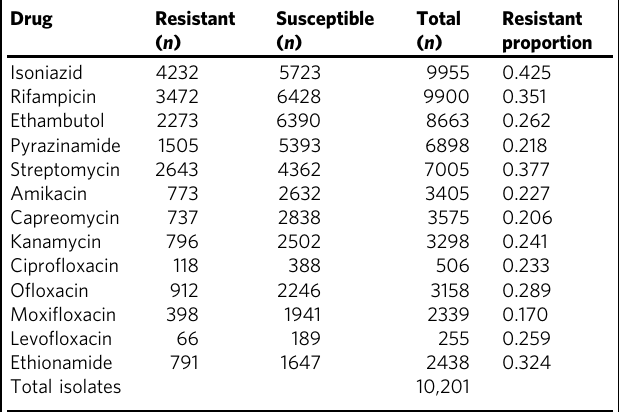
Table 1 Training set isolate phenotypes.